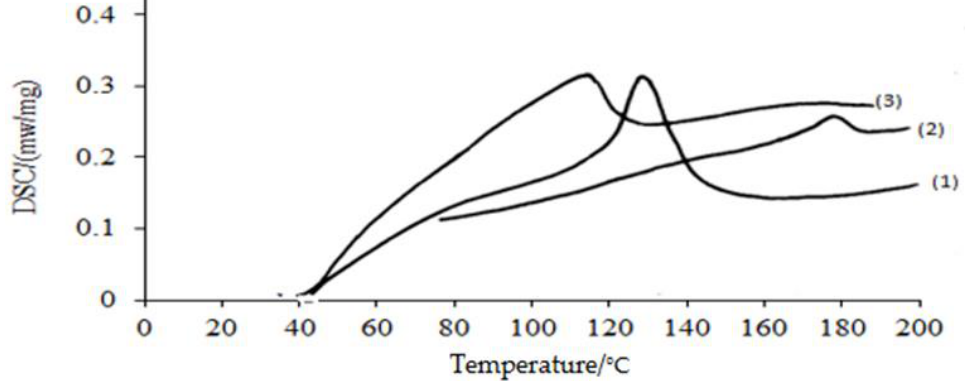
Figure 9. Differential scanning calorimeter diagram for the polypropylene samples. 1 — PP amidox- imated, 2 — PP-grafted, 3 — PP blank.